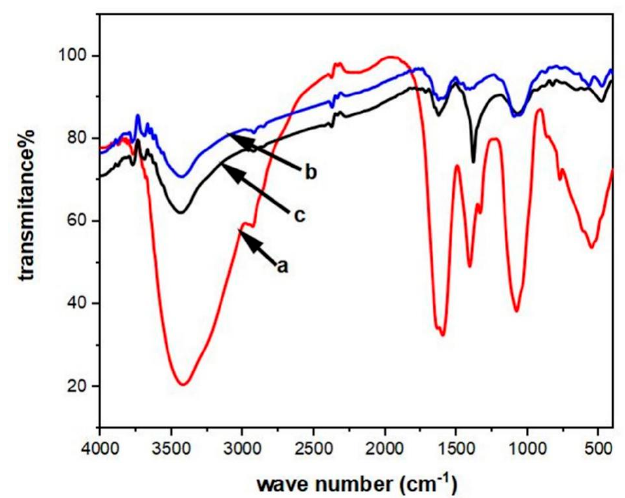
Figure 4. FTIR spectra of ( a ) tuber extract ( b ) AuNPs and ( c ) AgNPs.